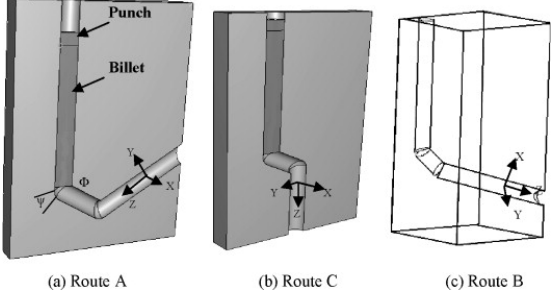
Figure 11. FEM (finite element method) models of ECAP reprinted with permission from Ref. [41]. Copyright 2022, ELSEVIER.